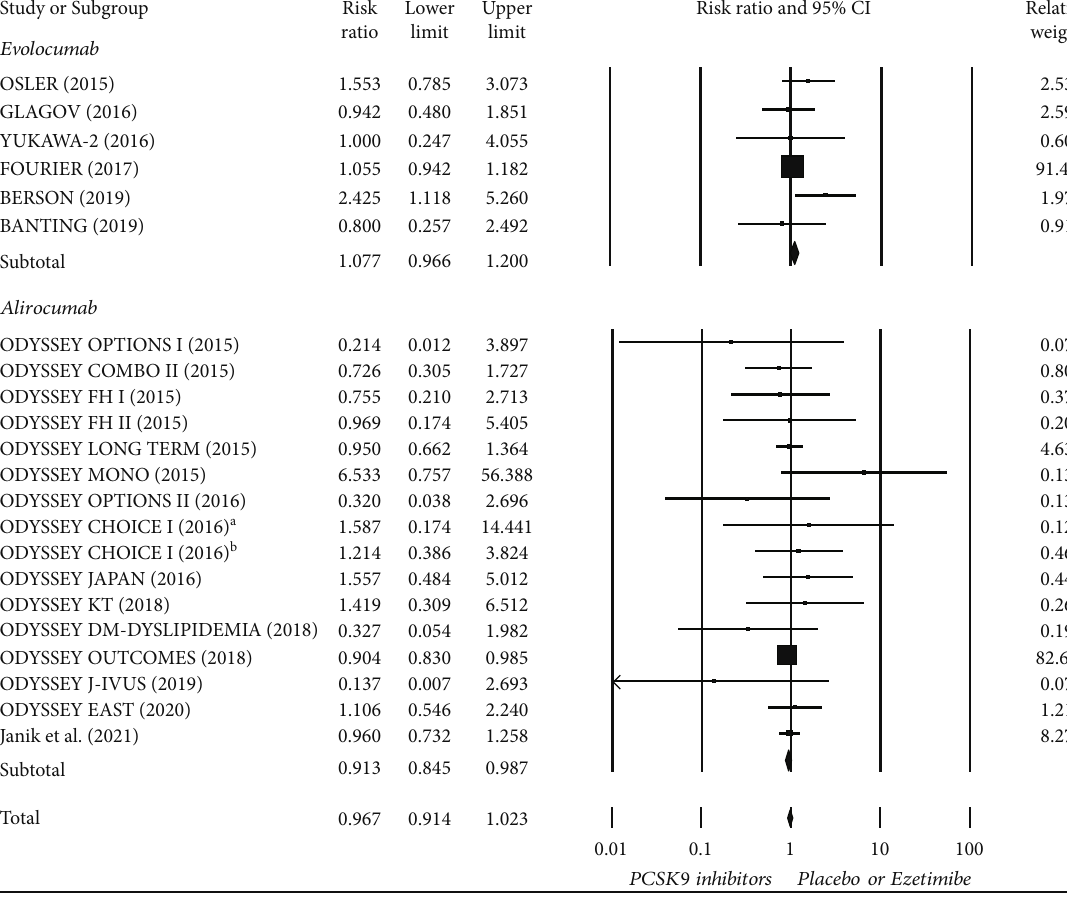
Figure 3: Forest plot of diabetes-related adverse events compared between PCSK9 inhibitors and control treatment (placebo or ezetimibe). a Treatment with alirocumab Q2W; b Treatment with alirocumab